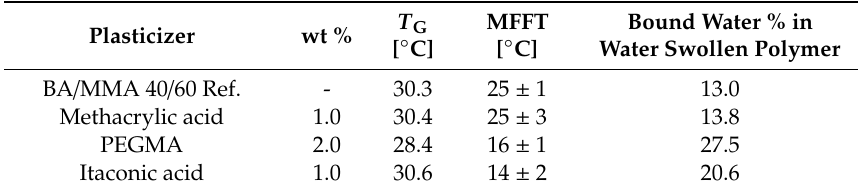
Table 3. MFFT, glass transition temperature ( T G ) and amount of bound water (%) calculated from DSC,